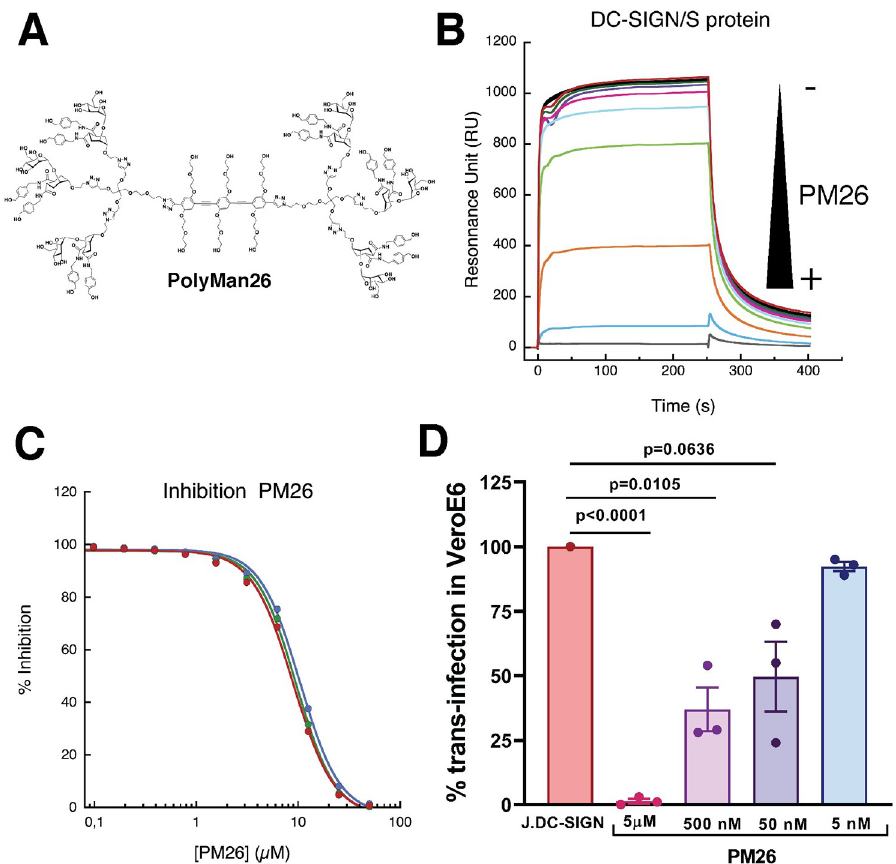
Fig 6. PM26, a specific antagonist of DC-SIGN, can inhibit DC-SIGN/S protein interaction and trans-infection of VSV/SARS-CoV-2. (A) Structure of Polyman26 (PM26). (B) Sensorgrams of DC-SIGN/S protein interaction inhibition by a range of PM26 concentration. DC-SIGN is injected at the constant concentration of 20 μ M, PM26 is co-injected at decreasing concentration going from 50 μ M to 0.1 μ M. S protein is presented in an oriented mode in the experiment presented here. (C) PM26 inhibition curve of the DC-SIGN/spike interaction using two independent oriented (blue, and green) or non-oriented spike surface (red) set up as described in Fig 2. The blue curve of inhibition derives from the sensorgrams presented in (B). Sensorgrams corresponding to the two others inhibitions curves are presented in the S2 Fig. (D) Inhibition of trans-infection of Jurkat DC-SIGN with SARS-CoV-2-pseudotyped rVSV- luc. Bars correspond to mean ± SEM of triplicates from an experiment of inhibition of SARS-CoV-2 trans-infection. Results are presented as percentage of SARS-CoV-2 trans-infection in the presence of PM26 as compared to trans- infection of SARS-CoV-2 in Vero E6 mediated by Jurkat DC-SIGN without addition of any compound. Trans- infection bar for Jurkat DC-SIGN established as 100% of the trans-infection correspond to the mean of triplicates of SARS-CoV-2 trans-infection by Jurkat DC-SIGN without addition of any compound.SARS-CoV-2-pseudotyped rVSV-luc was used at MOI: 1. Individual results are presented as scattered dot plot. Statistical significance was calculated in panel D by t-test ( � p < 0.05, �� p < 0.01, ��� p < 0.001, ���� p < 0.0001). The IC 50 value for PM26 was estimated using GraphPad Prism v8 with a 95% confidence interval and settings for normalize dose-response curves (IC 50 = 94 nM, 95%CI = 35 nM– 249